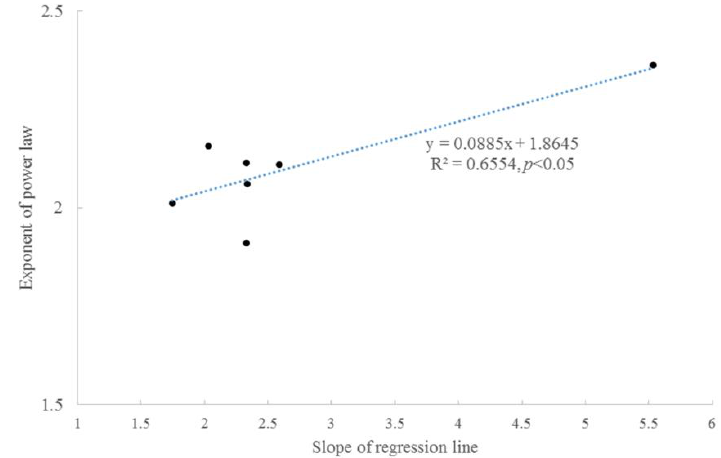
Figure 5. Correlation between the scaling exponents of Taylor’s power law and the slopes of fitting lines between accumulated radial growth and time.